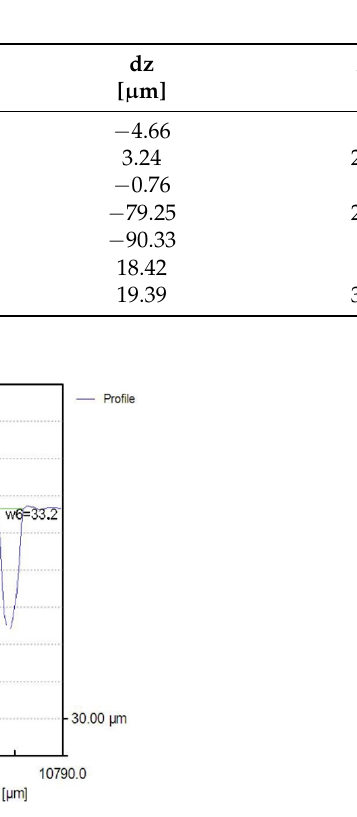
Figure 10. 2D profile and dimensions of rectangular microchannels used for coolant